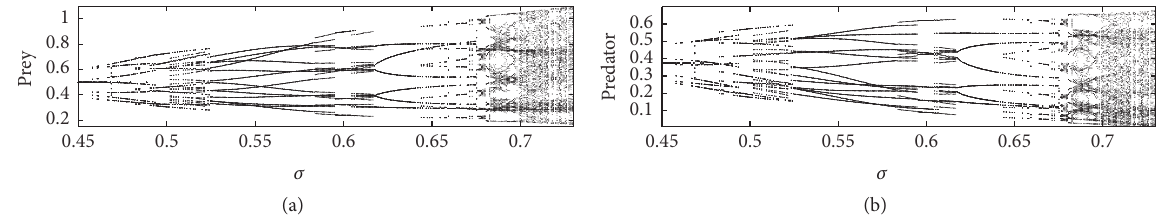
Figure 3: Bifurcation diagram for system (6):The parameter values are fixed as follows: 𝑝 = 0.1, 𝜏 = 0.3, 𝜎 = 0.43, 𝛽 = 4, 𝛼 = 3, 𝛿 = 2.0 , and ET =